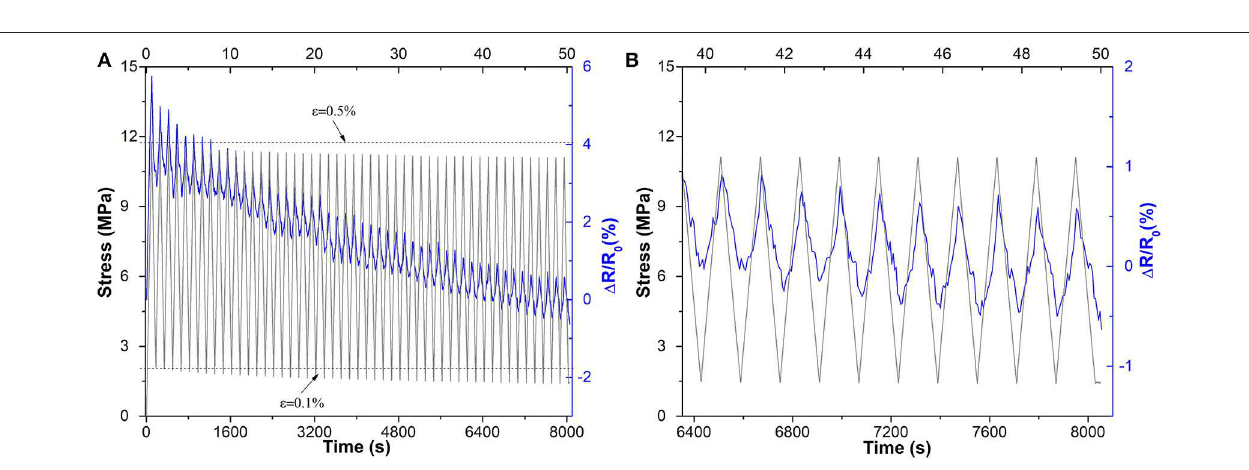
FIGURE 10 | Piezoresistivity of the H45 samples in reversible mode (A) 50 strain cycles under tensile loading and (B) detail of the last 10